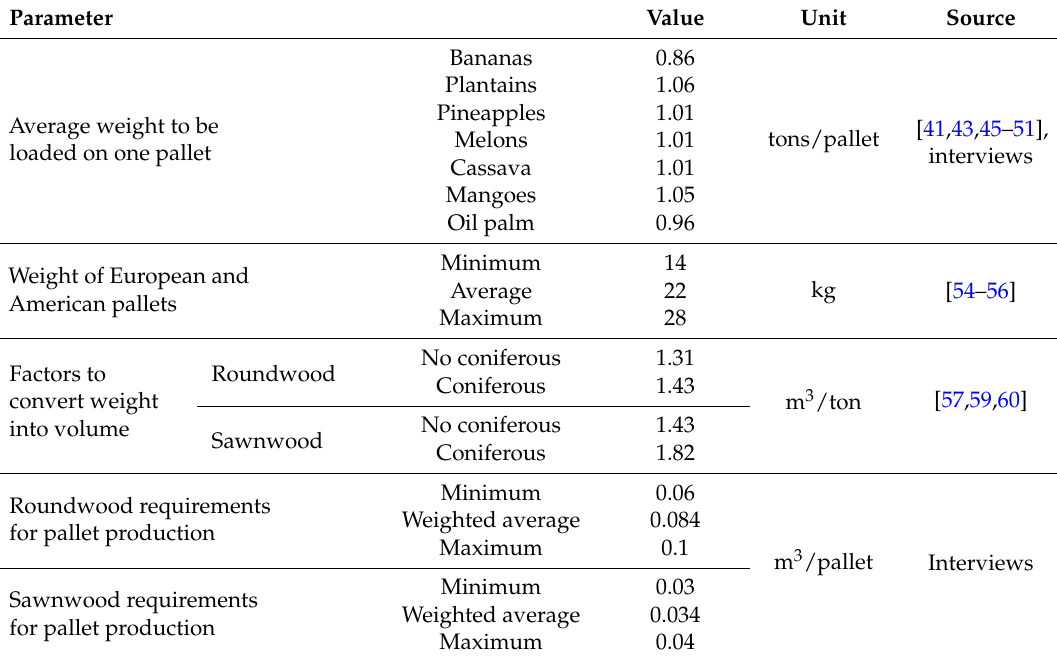
Table A1. Summary of the parameters used in the different steps of the